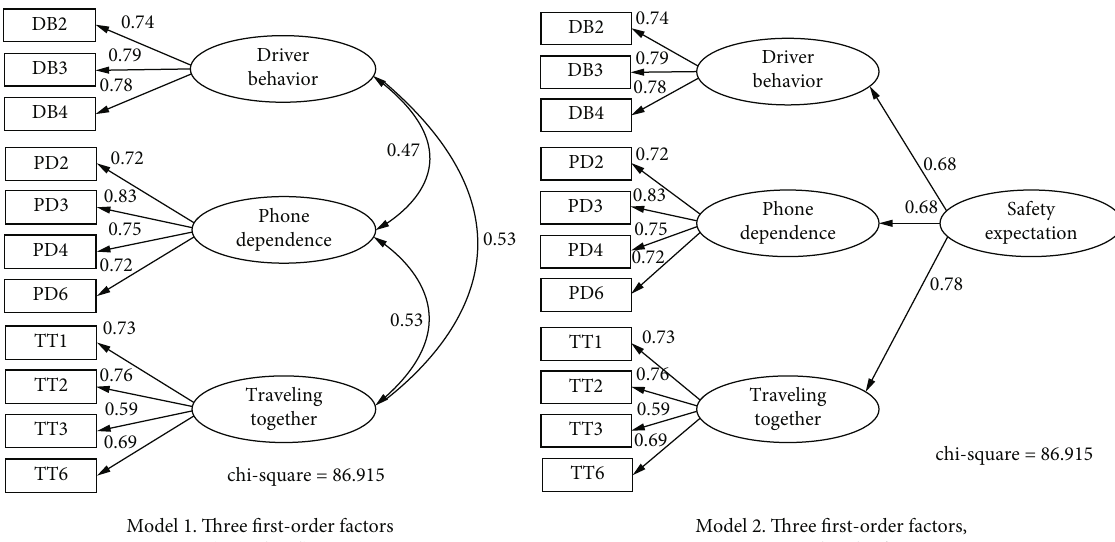
Figure 3: Alternative